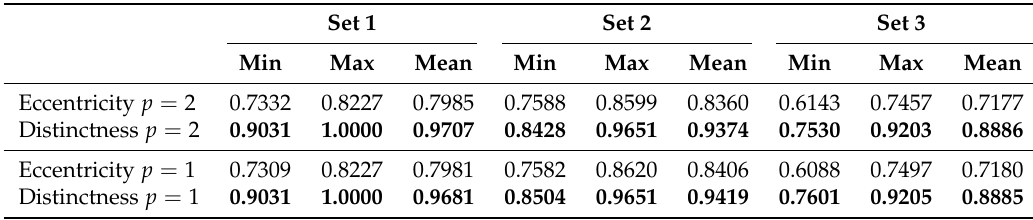
Table 4. Distinctness versus eccentricity [23]. Each reported statistics is estimated using 6 NMIs. In each comparison, the higher performance is marked as bold. Set 1 Set 2